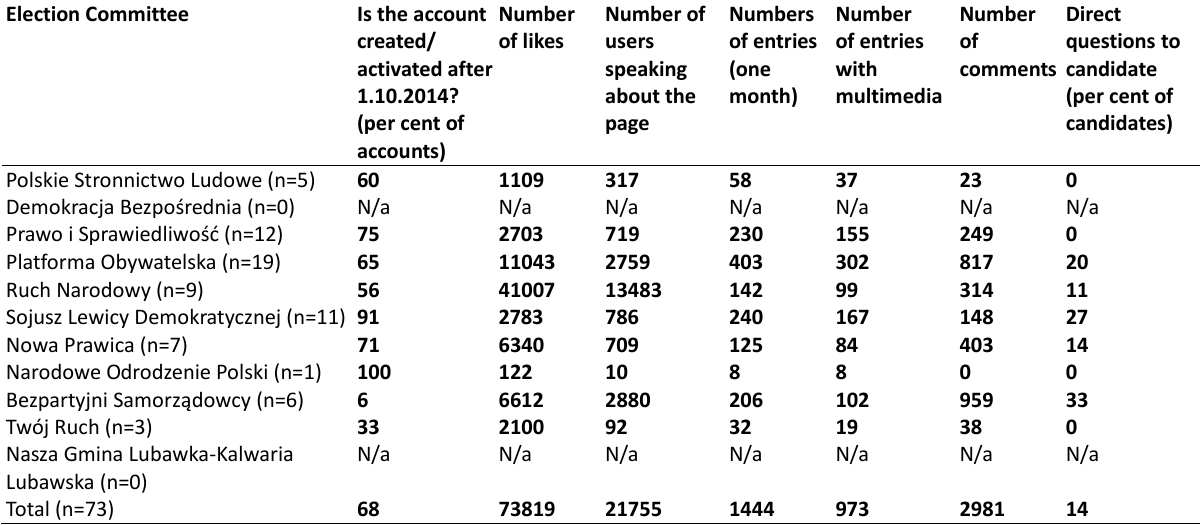
Table 4. Lower Silesia Regional Assembly candidates on Facebook.